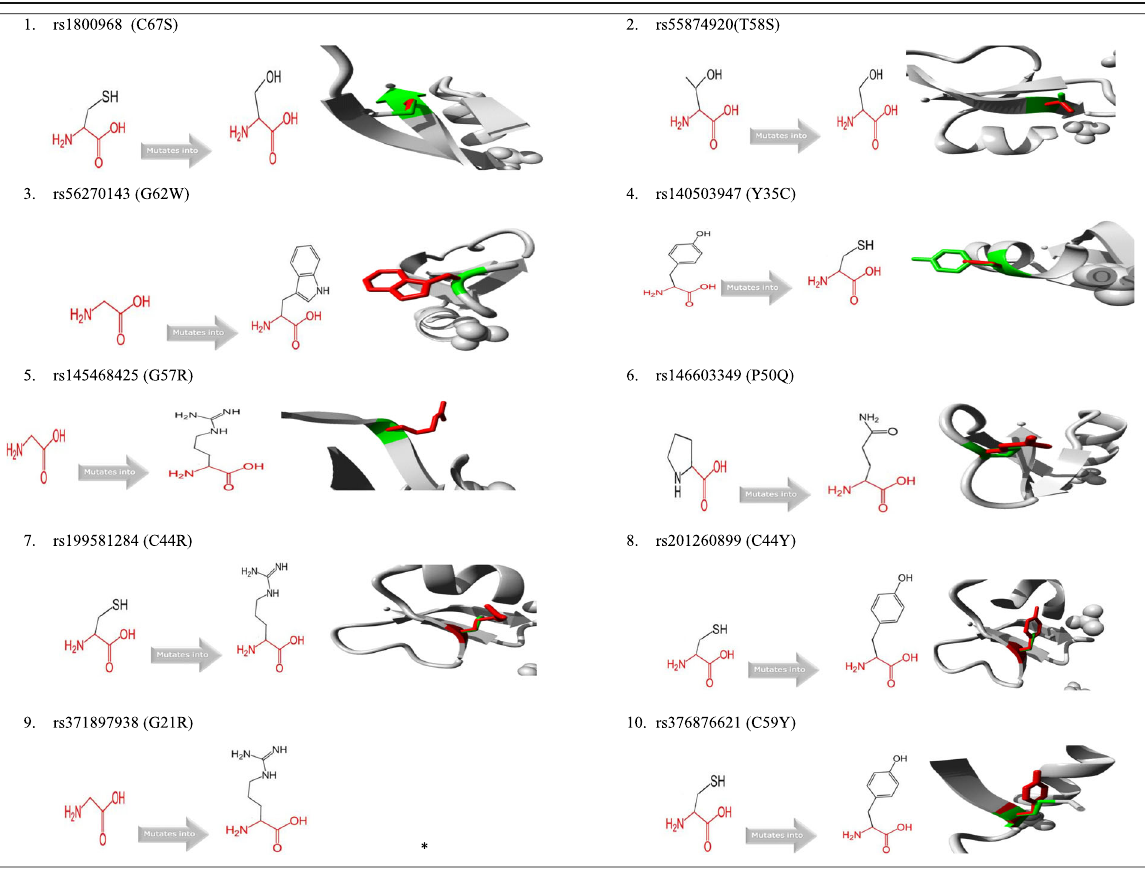
Table 5 Results of the 3D predictions of β -defensin 1 protein by Project HOPE. The protein is colored gray ; the side chains of both the wild-type and the mutant residue are shown and colored green and red